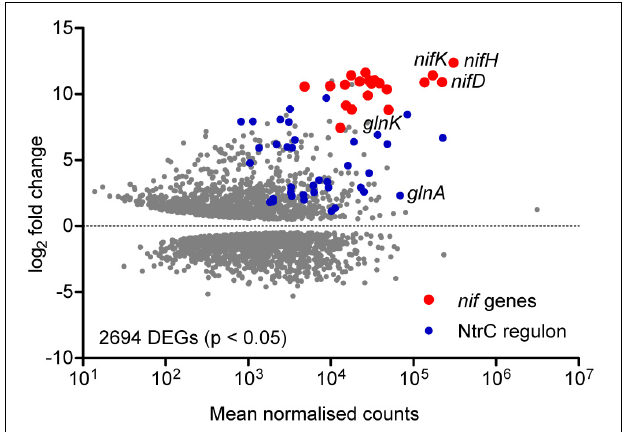
FIGURE 2 | Exploratory analysis of the diazotrophic transcriptome. MA plot of the log 2 fold change and mean RNA-seq read count for all Ko M5a1 genes. Gray points represent differentially expressed genes (DEGs) in N-fixing conditions (0.5 mM NH 4 Cl run-out) with respect to N-replete (10 mM NH 4 Cl) conditions, with adjusted p -values of < 0.05 as determined by DESeq2. Read counts were averaged (mean) across all N-fixing and N-replete samples and normalised using the regularised logarithm (rlog) transformation. DEGs belonging to the known nif and NtrC-dependent regulons are highlighted in red and blue,